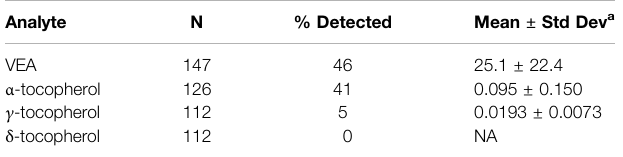
TABLE 4 | VEA and other tocopherols concentrations and detection frequency in aerosol emissions of EVALI case-associated EVPs (µg per mL aerosol puff